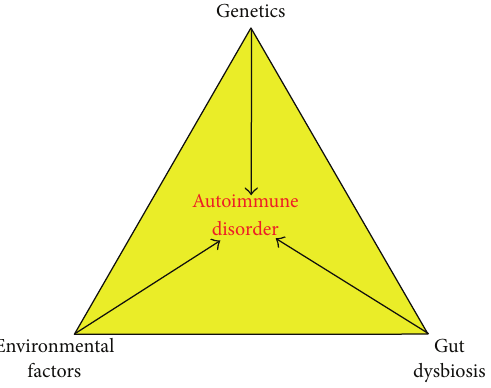
Figure 1: The triangle of autoimmune triggers. Gut dysbiosis and genetic and environmental factors play major roles in the development of autoimmune